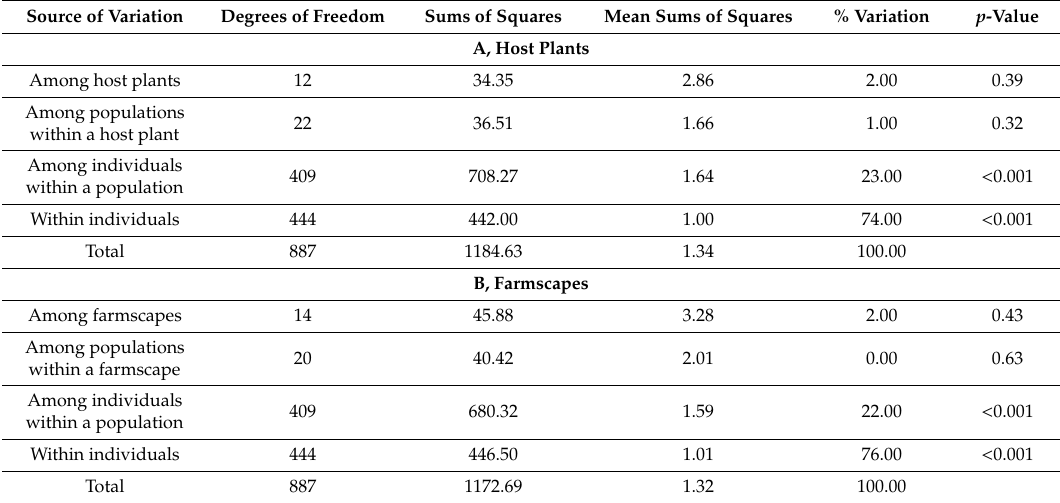
Table 9. Hierarchical analysis of molecular variance (AMOVA) for the 35 B. tabaci MEAM1 populations collected from Georgia, USA, based on six microsatellite markers. ( A ) Among populations collected from di ff erent host plants. ( B ) Among populations collected from di ff erent farmscapes.